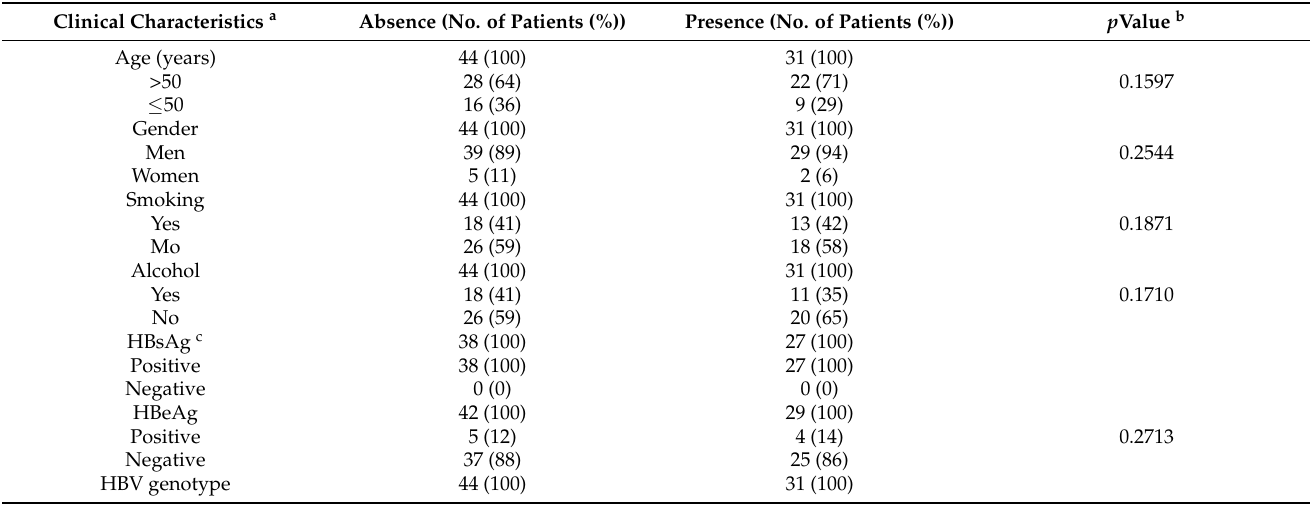
Table 2. Clinicopathological correlation of deletion spanning the pre-S2 gene segment in 75 HBV-related HCC patients. Clinical Characteristics